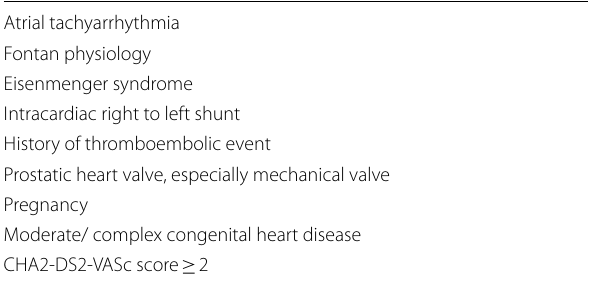
Table 1 Indication for anticoagulation in adult congenital heart disease Atrial tachyarrhythmia Fontan physiology Eisenmenger syndrome Intracardiac right to left shunt History of thromboembolic event Prostatic heart valve, especially mechanical